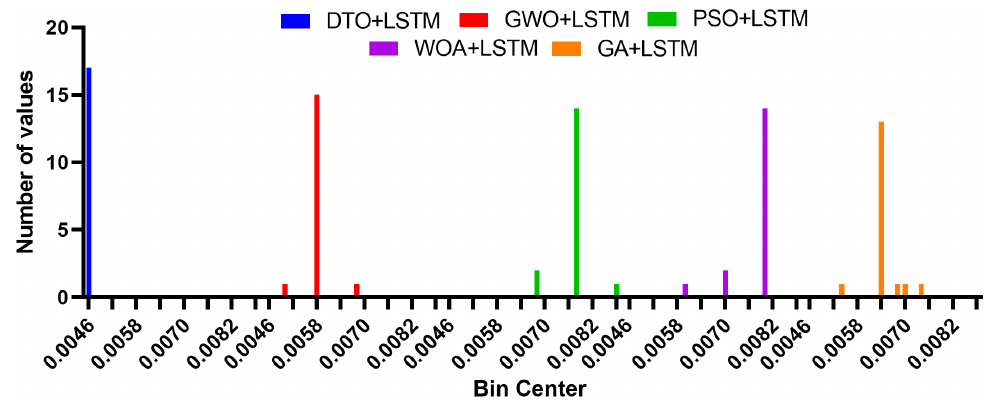
Figure 8. Histogram of the error values of the energy consumption prediction results.